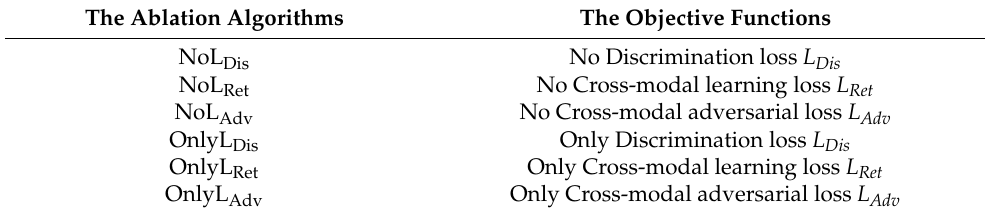
Table 3. Comparative algorithms in the ablation experiments.